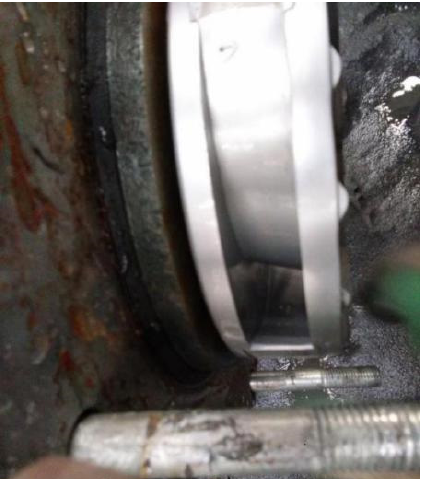
Figure 21. Photograph of impeller wear in the first stage (direction of the outlet side).